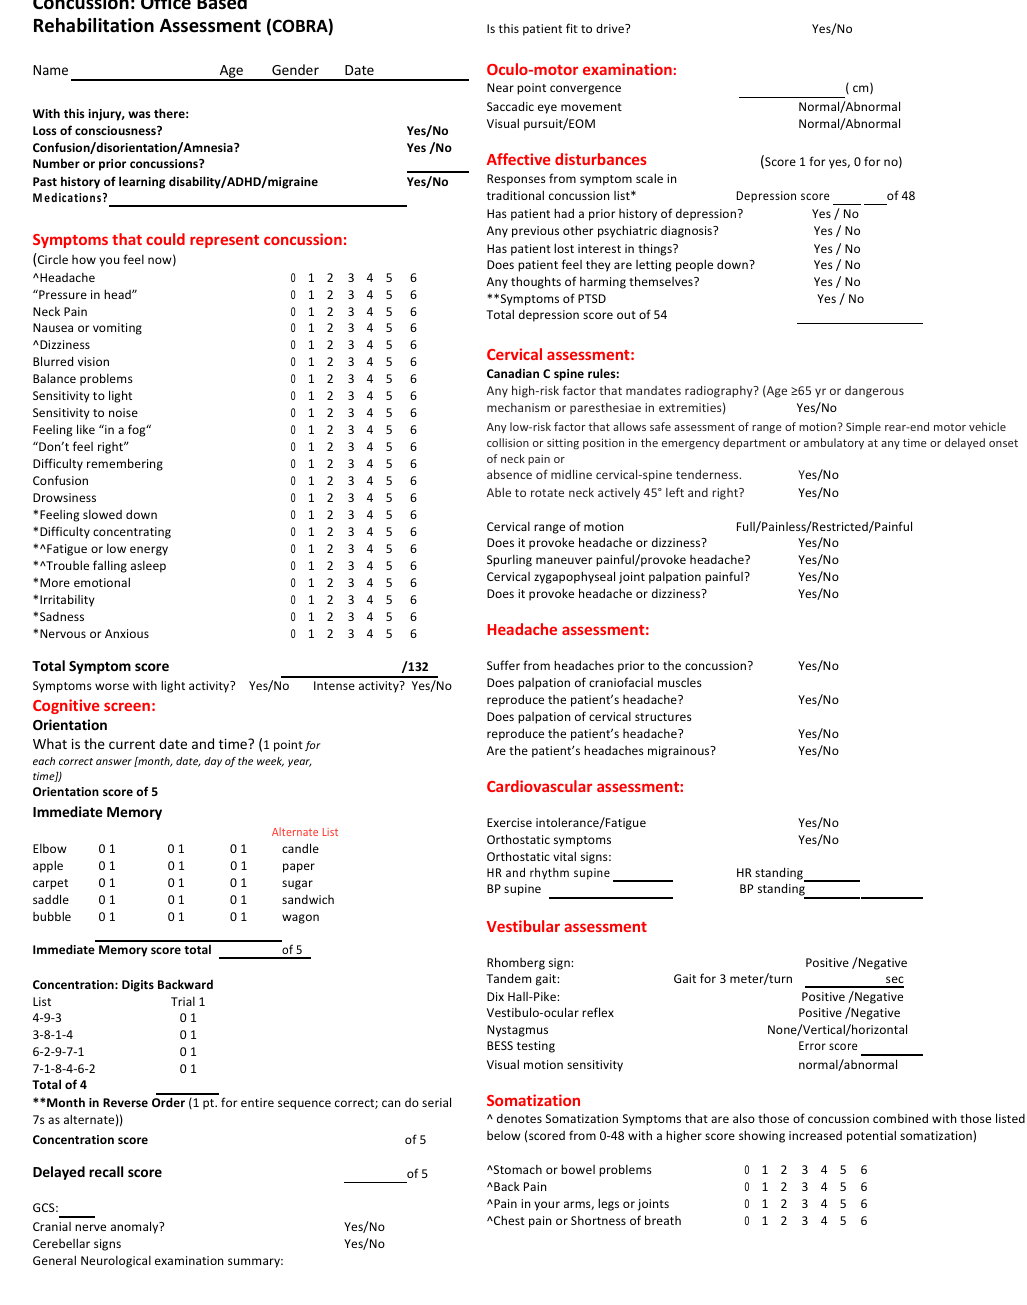
Cervical assessment: Canadian C spine rules: Any high-risk factor that mandates radiography? (Age ≥65 yr or dangerous mechanism or paresthesiae in extremities)